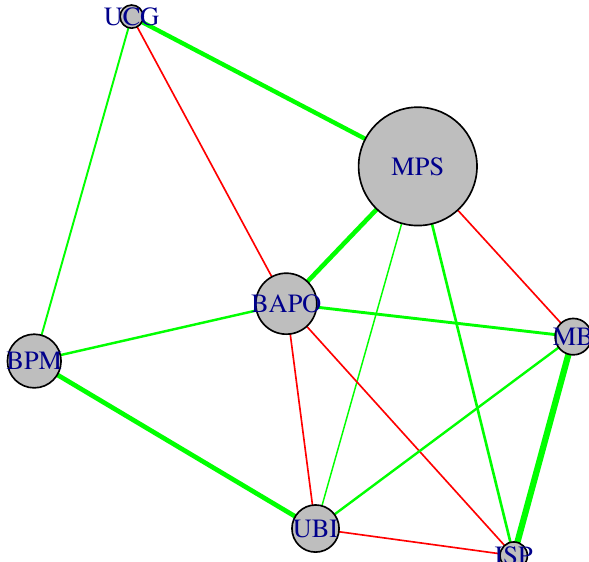
Figure 4. Partial correlation network, Italian banking system, function of CDS spreads. Notes: Partial correlation network between seven Italian banks, based on partial correlations between expected losses. The size of each node in the network is proportional to the average CDS spreads of the corresponding bank. Green lines indicate positive partial correlations, while red lines stand for negative partial correlations. The thicker the line, the stronger the connection. Non-significant partial correlations have been omitted.